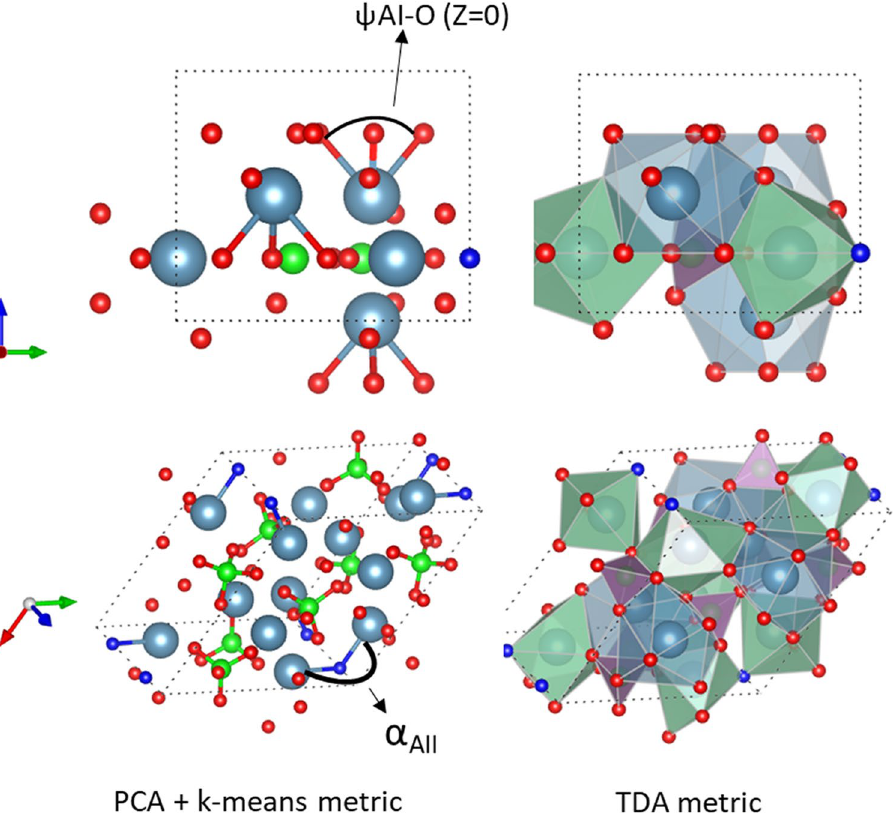
Figure 7. Comparison of the features identified as most critical from the prior PCA + k-means approach 16 and the TDA approach described here. In the case of the prior work, critical bonds are identified, while the TDA approach captures a more complete representation by accounting for the bonds and geometry of the coordination polyhedra. The bonds are seen to be represented in by the coordination polyhedra, with ψA1– O1 captured by the CN = 9 polyhedra (blue polyhedra), while α AII shows up in the CN = 7 polyhedra (green). Neither bond shows up within the CN = 4 polyhedra (purple), indicating that the prior approach did not identify B site chemistry to have a major impact in defining similarity of